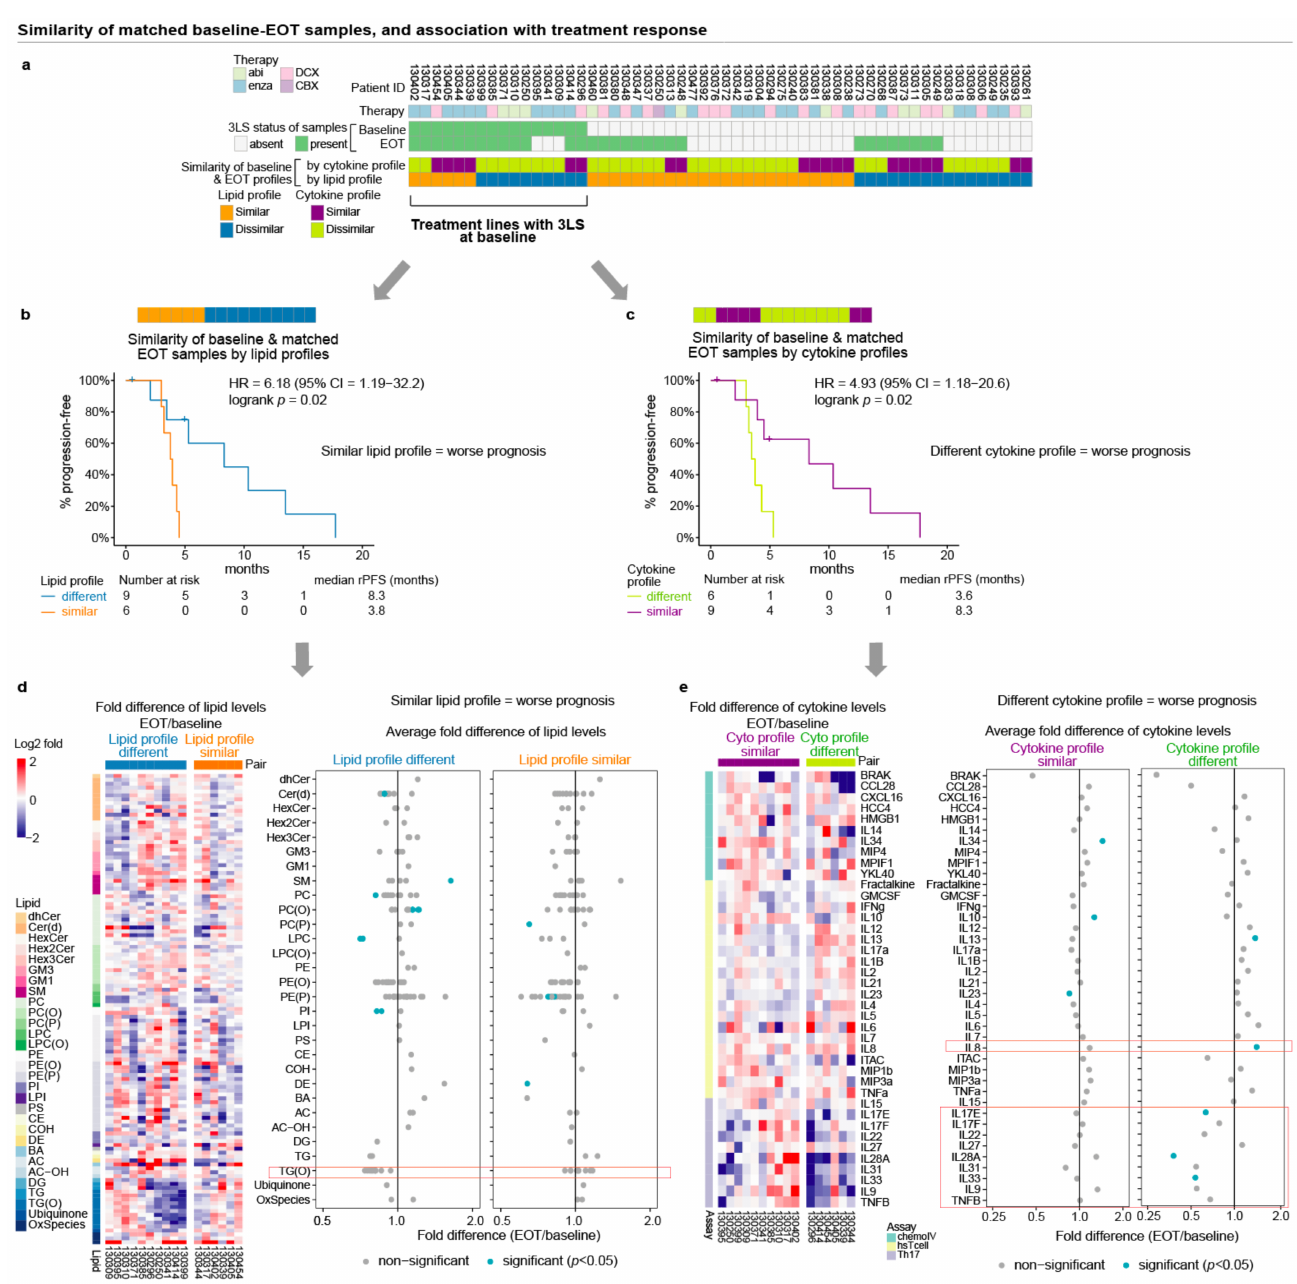
Figure 6. Association of prognostic lipid profiles with treatment response in Cohort 2b: ( a ) Status of 3LS and similarity of matched baseline and EOT samples according to hierarchical clustering from Figure 5; ( b , c ) Kaplan–Meier curves of rPFS for treatment lines with 3LS at baseline, stratified by similarity of baseline EOT lipid or cytokine profiles; ( d , e ) lipid and cytokine fold change at EOT displayed as heatmap of fold change for each baseline EOT pair and forest plot of average fold change. Lipids/cytokines with notable changes are indicated by the orange outline in the forest